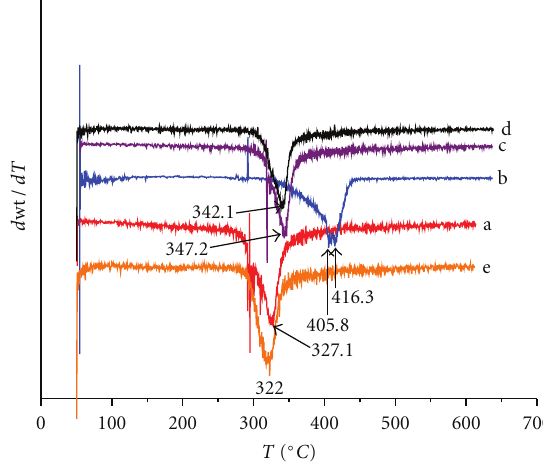
Figure 6: XRD patterns for (a) CS rod, (b) CHF, and (c) CHF/CS (0.5/100, wt/wt).